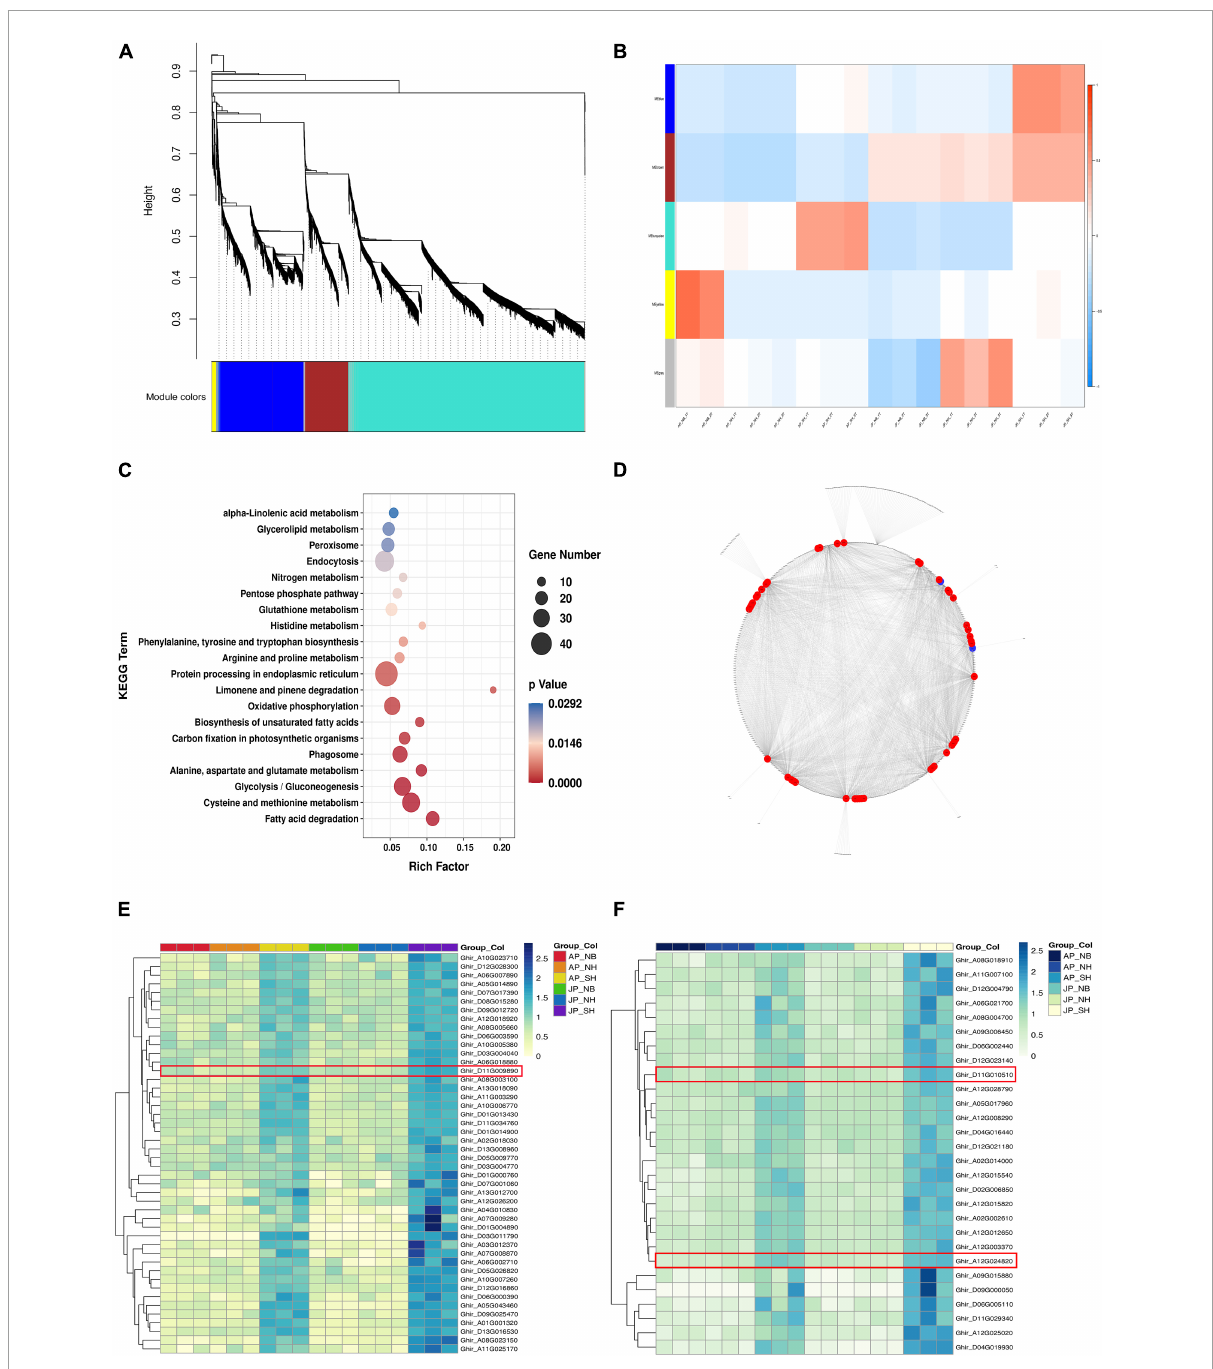
FIGURE5 (A) Overview of a weighted correlation network analysis based on differentially expressed genes (DEGs). (B) The module–sample relationships. (C) Pathways of enriched genes in blue module. (D) Co-expression network of genes in the blue module. The red node represents the expression pattern of the hub gene in cluster 1, and the blue node represents the expression pattern of the hub gene in cluster 2. (E,F) The clustering heat maps of hub genes in cluster 1 (E) and cluster 2 (F) .